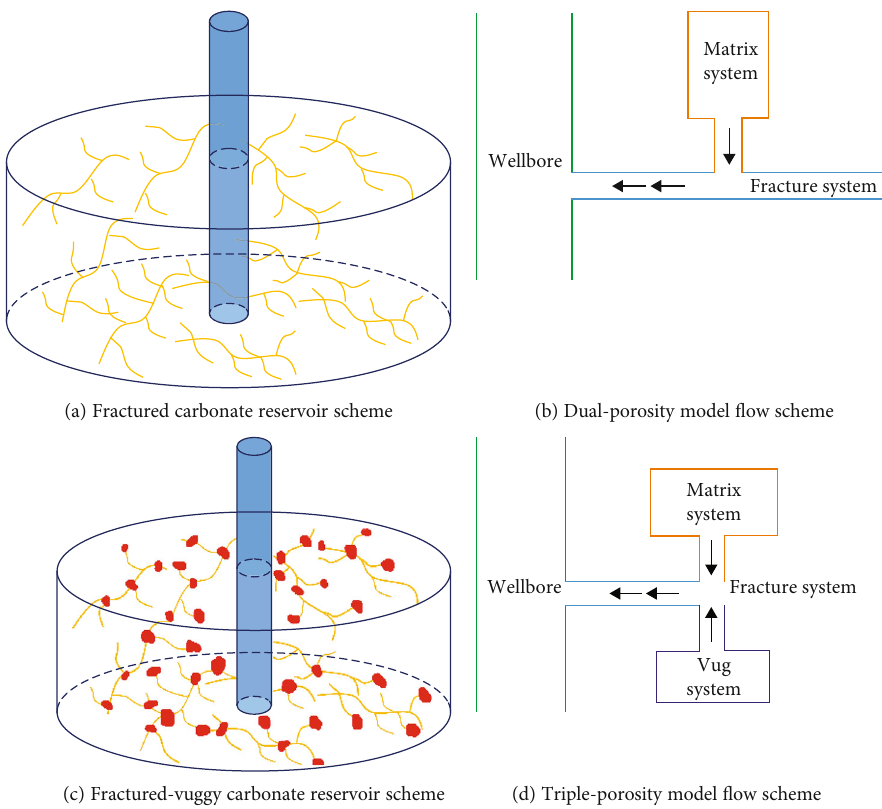
Figure 2: Description of the dual-porosity and triple-porosity models in this paper.